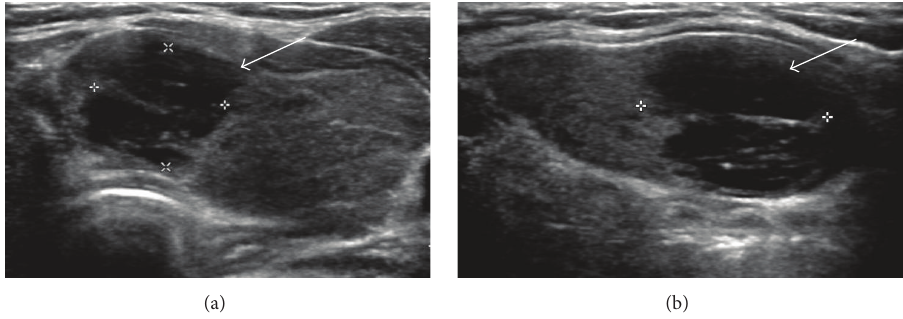
Figure 2: Four years later, image of the left thyroid nodule (a) in transverse view and (b) longitudinal